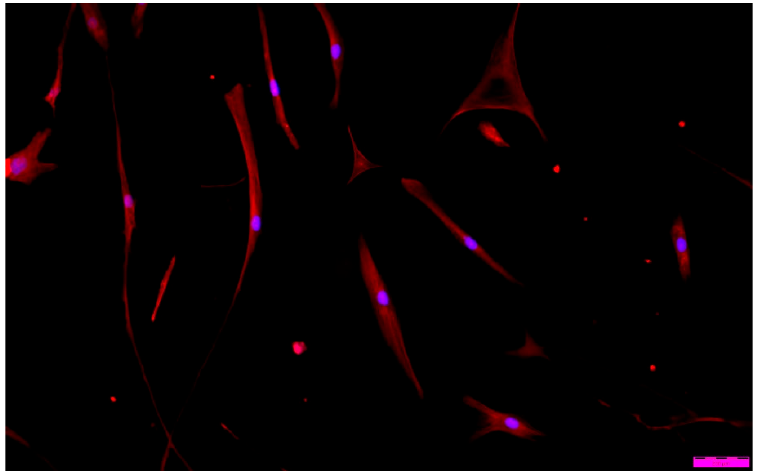
Figure 13. Fluorescence microscopy image of human fibroblast cells cultured in the presence of a cross-linked alginate–perfluorooctyl coating ((ALG-PFC) net ) after a 6-day culture.